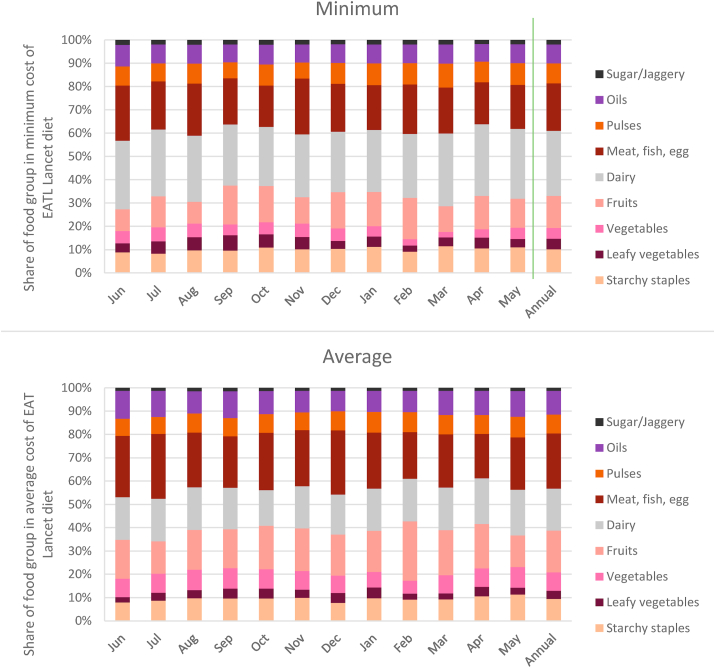
Food group shares in cost of EAT Lancet diet, June 2018–May 2019.